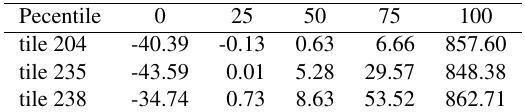
Table 2. Asolute variation of annual solar irradiation per sensor point. Values are expressed in kWh/m 2 . The tile IDs refer to Figure